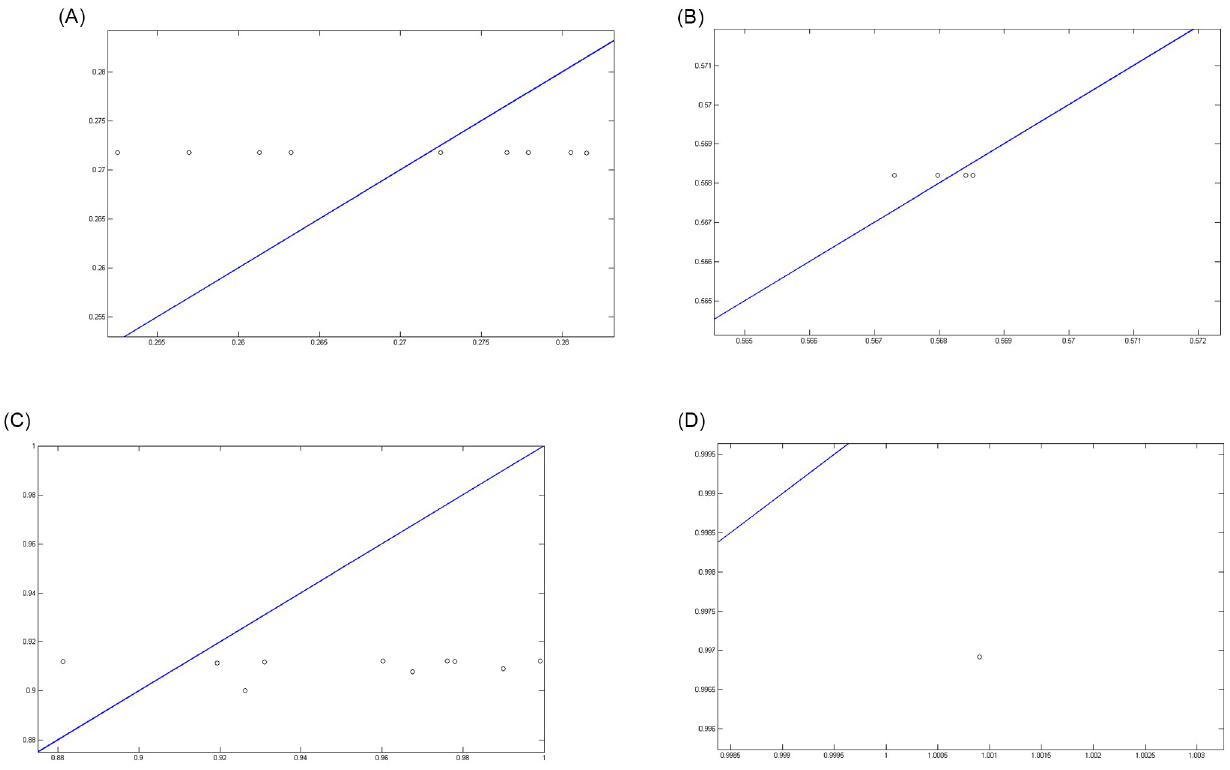
Fig 11. The closest answer to the regression line (regression function) obtained with ANN-BTA in the training samples: (Fig 11A)[0.1, 0.4], (Fig 11B)[0.4, 0.7], (Fig 11C)[0.7, 1] and (Fig 11D)[1, 1.3] range.